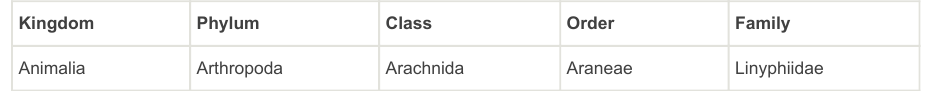
Troglohyphantes subalpinus Thaler, 1967